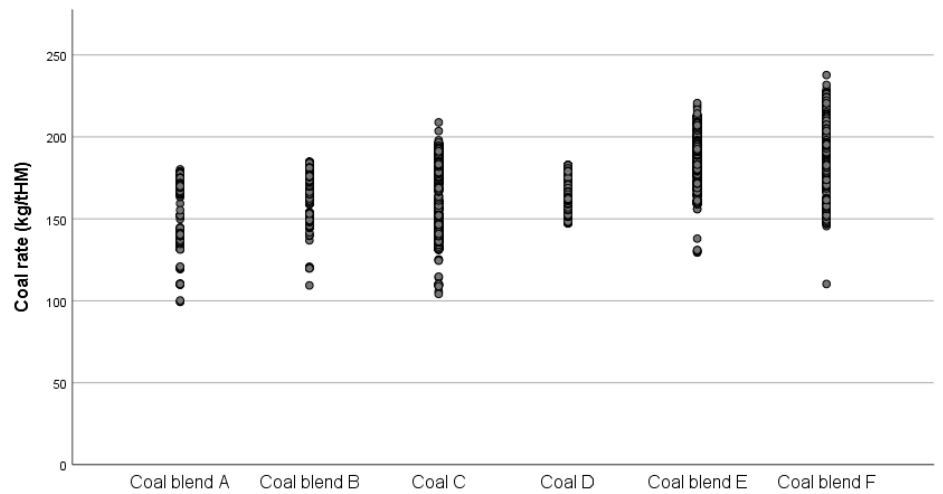
Figure 9. The range of the coal injection rates for each of the coals/coal blends used during the trial period of blast furnace production.